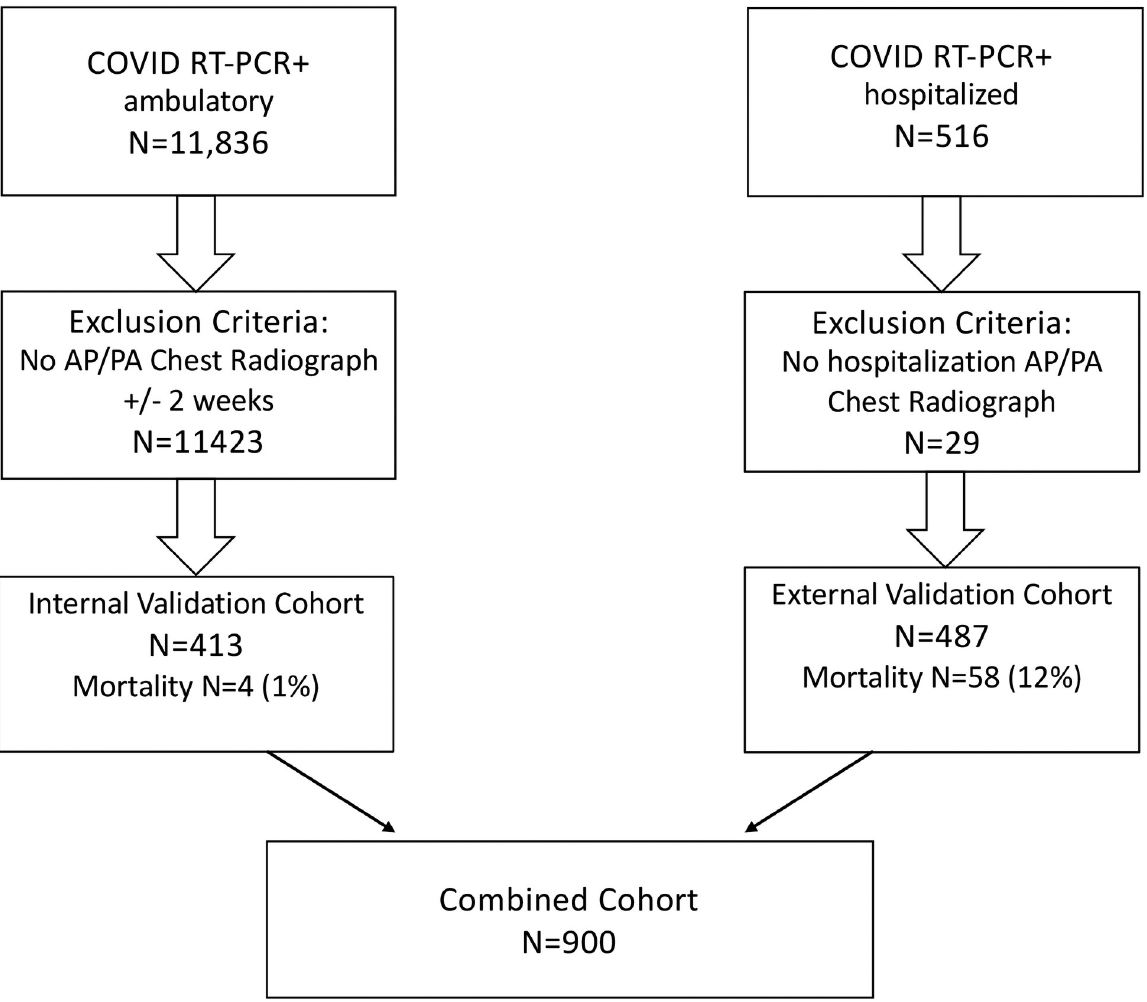
Fig 1. Flowchart of patient inclusion. Patients with absent or negative real-time reverse transcription polymerase chain reaction (RT-PCR) test results were excluded. COVID-19 = coronavirus disease